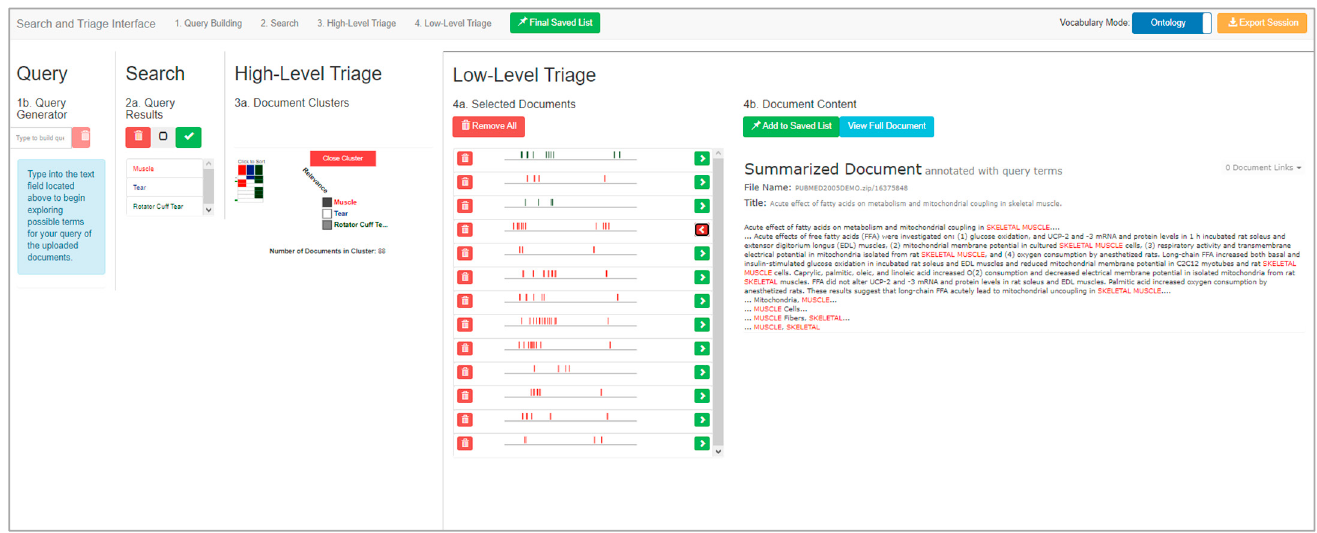
Figure 13. An overview of the low-level triage subview within VisualQUEST.